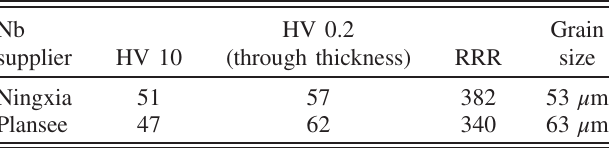
TABLE I. Hardness, RRR, and grain size of niobium material used for electrohydraulic forming (Ningxia) and for spinning